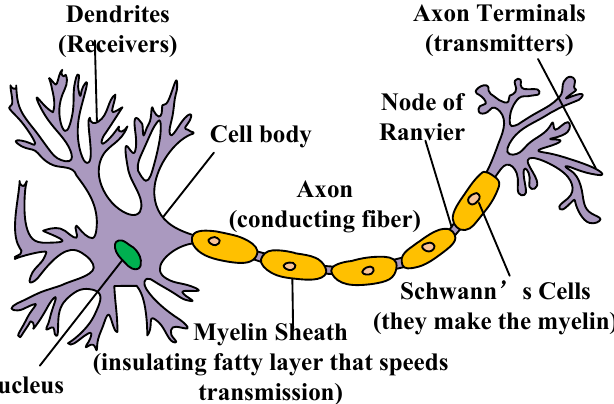
Figure 1. Neuron structure